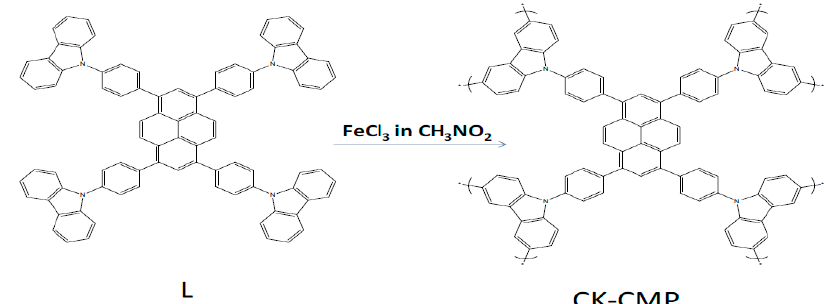
14 of 33 Figure 13. Electrochromic study of the ( a ) P(PhCz-2Cz) and ( b ) P(TPA-2Cz). Reproduced with permission from [143]. Copyright (2015) Elsevier. The same strategy was used in other work of Hsiao and Lin [141] in which poly(amide-